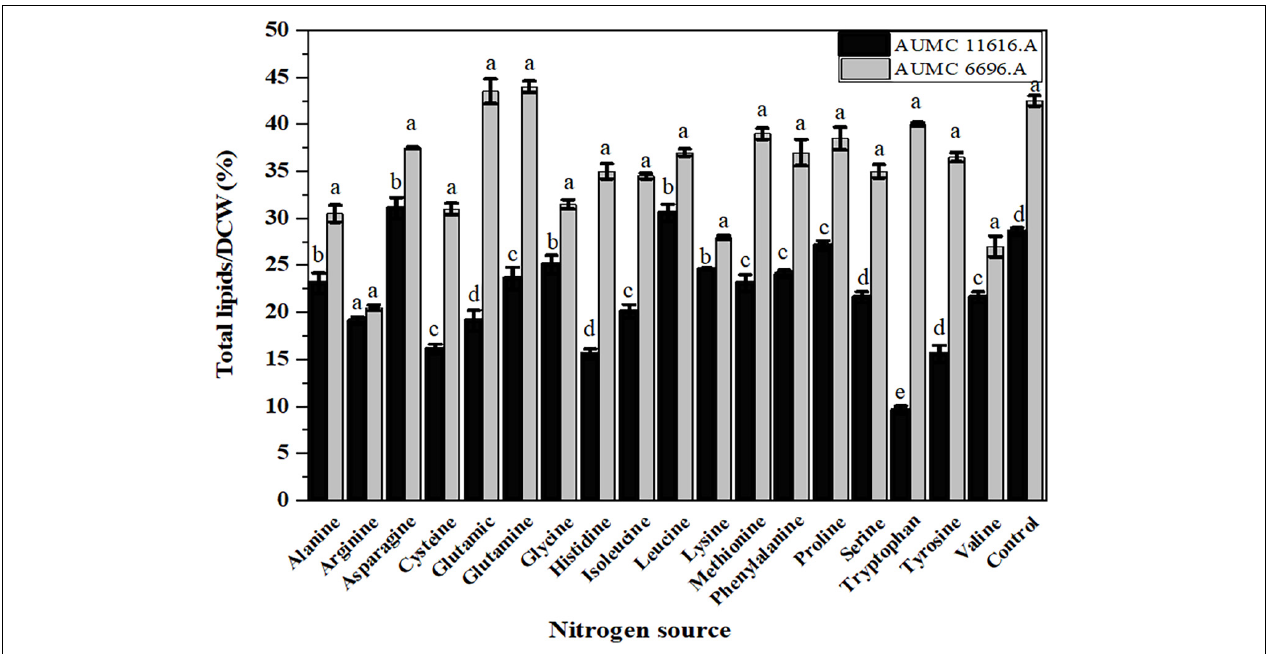
FIGURE 4 | Total lipids production of R. pusillus AUMC 11616.A and M. circinelloides AUMC 6696.A strains grown at 30 ◦ C for 4 days, on different nitrogen sources. Ammonium tartrate was employed as the control. Error bars represent the average standard deviation from three biological replicates. Values that show different superscripts were significantly different from each other using t -test ( p < 0.05).